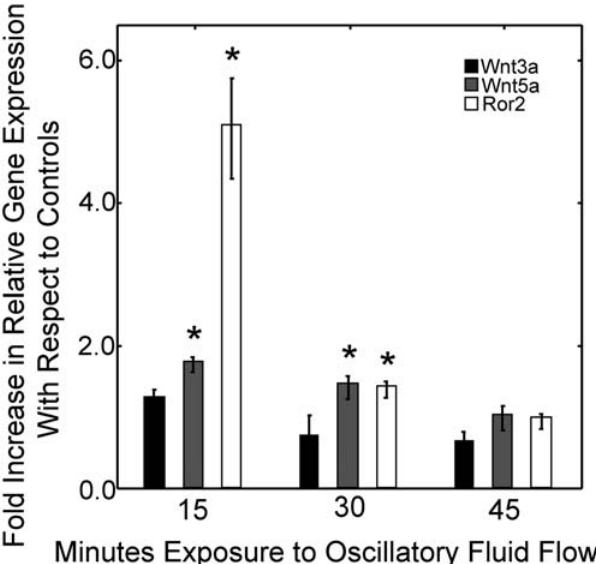
Figure 2. Non-canonical related Wnt proteins are regulated by oscillatory fluid flow. To determine if Wnt expression was regulated by mechanical stimulation, MSCs were exposed to 15, 30 and 45 minutes of flow and lysed immediately. The canonical Wnt, Wnt3a was not affected by flow exposure. However, non-canonical associated Wnt5a and tyrosine kinase receptor, Ror2, were significantly upregu- lated with 15 and 30 minutes of flow. Wnt5a expression was increased 1.8 6 0.1-fold (p , 0.01) in cells exposed to 15 minutes of flow versus control cells and was maintained after 30 minutes of flow to be 1.5 6 0.2-fold (p , 0.05). Ror2 expression was increased 5.1 6 0.7-fold (p , 0.01) in cells after 15 minutes of oscillatory fluid flow and 1.4 6 0.1- fold (p , 0.05) after 30 minutes. C3H10T1/2 MSCs did not express canonical Wnt7b or Wnt10b. (Error bars: SEM (n $ 10)).